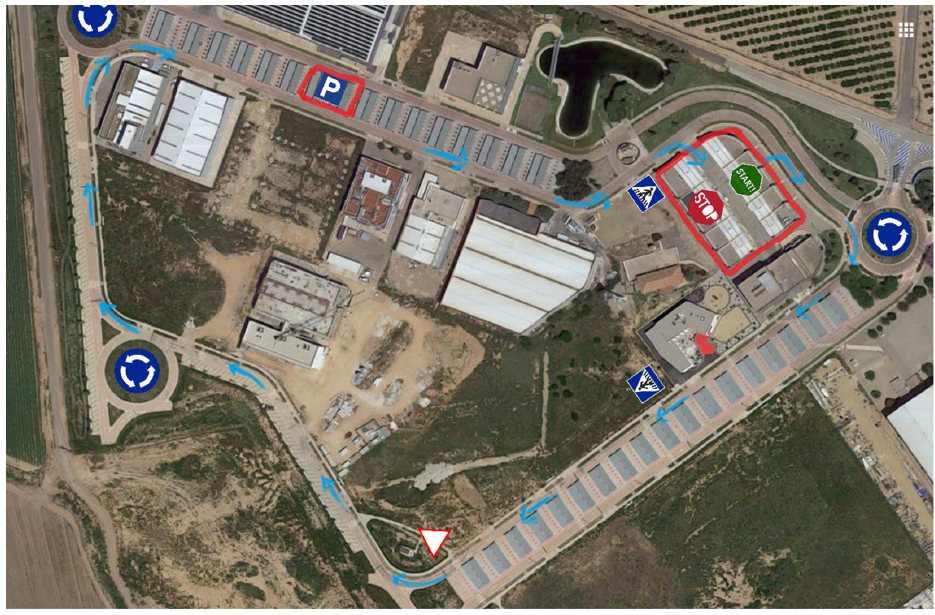
Figure 1. Urban route selected for the driving tests.